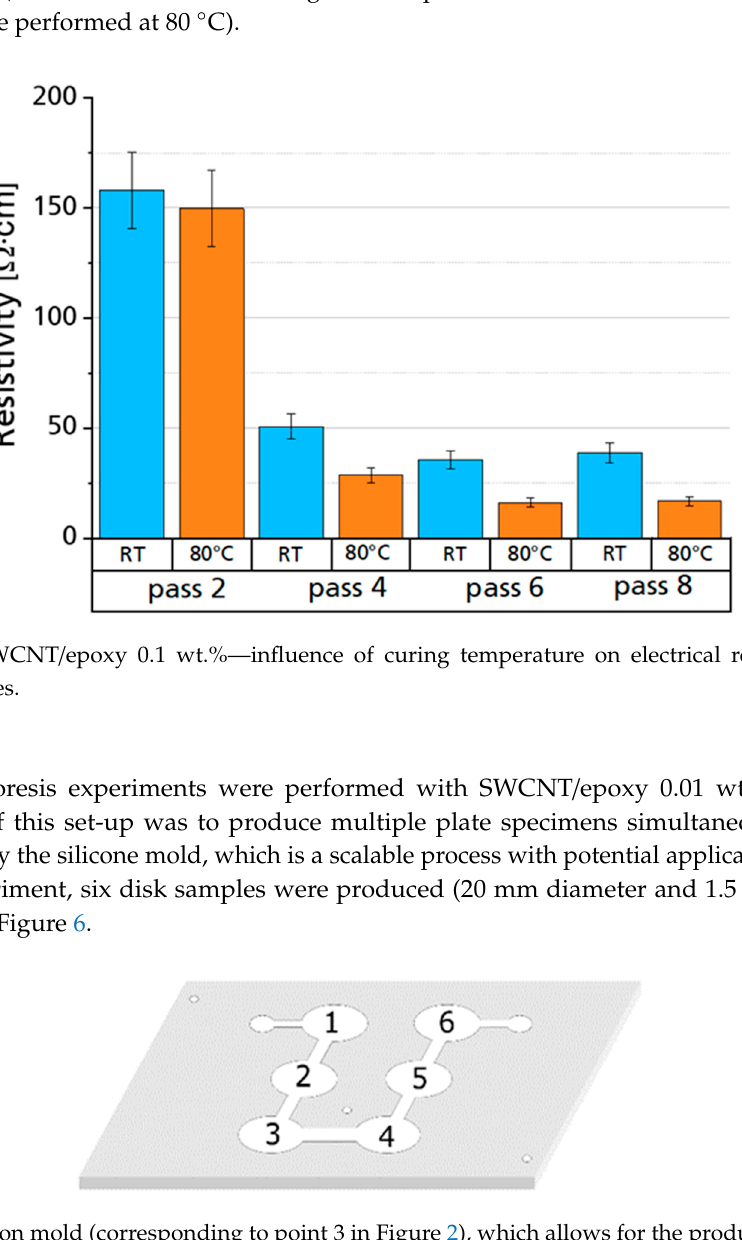
Figure 6. Silicon mold (corresponding to point 3 in Figure 2), which allows for the production of six discs of 20 mm diameter per 1.5 mm thickness.